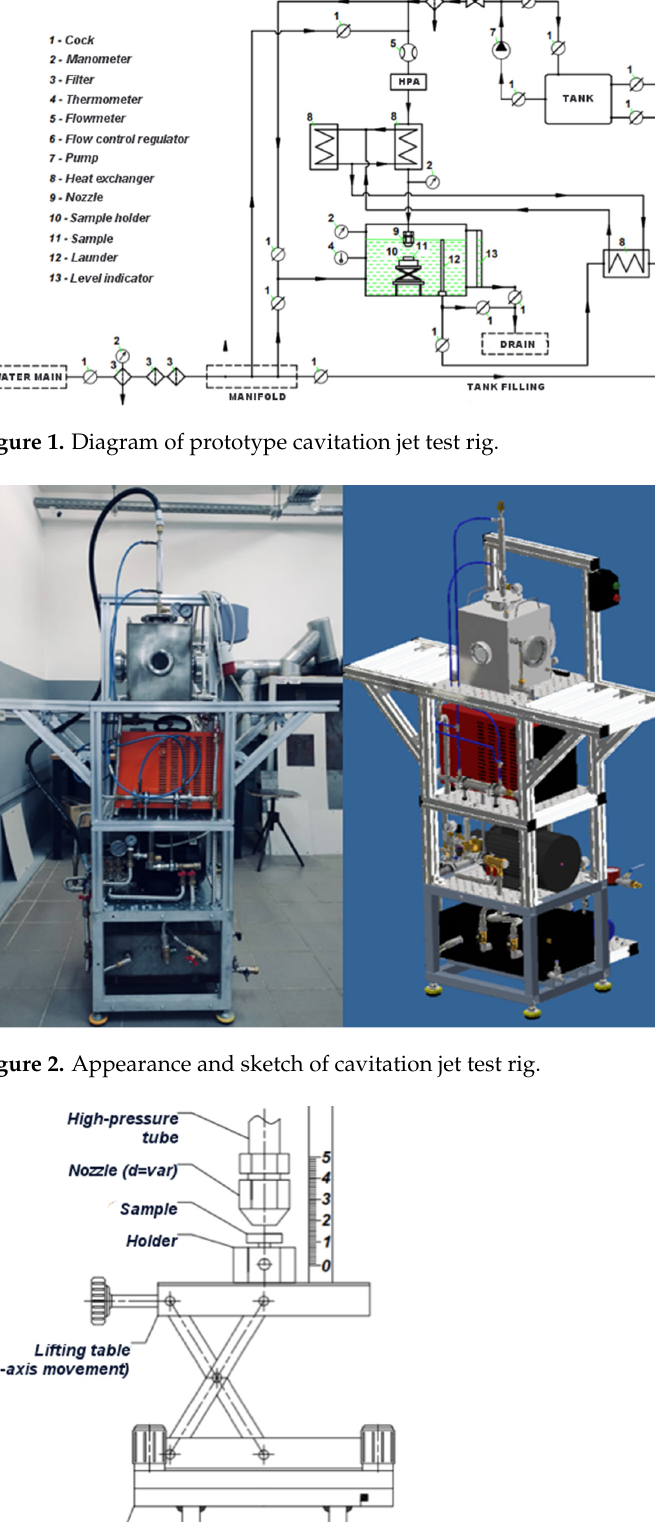
≤ 0.1 Figure 4. Microstructure of uncoated aluminum sample. After cavitation tests, the surface of coated aluminum samples was examined using a scanning electron microscope and a mechanical stylus profiler. Settings of the SEM microscope are given in Table 3.